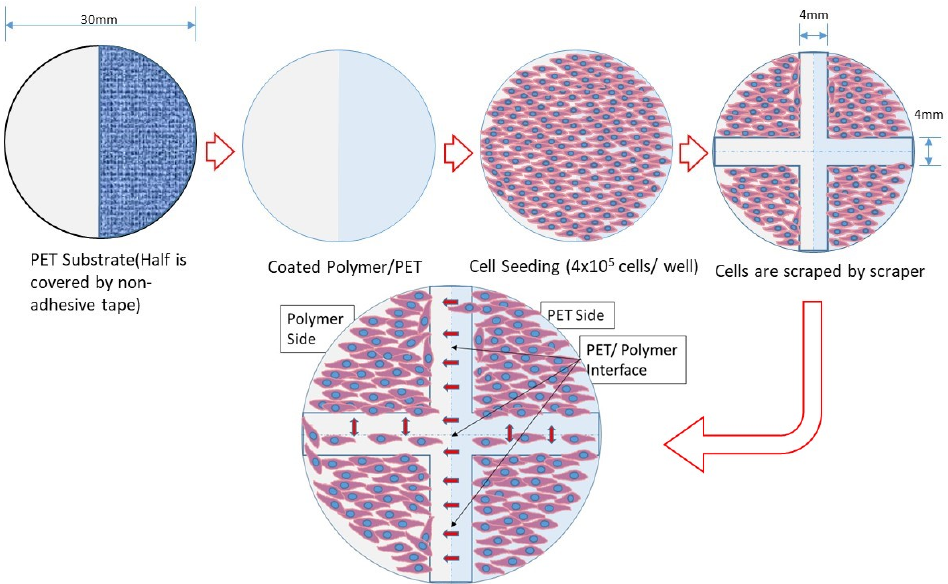
Figure 2. Schematic representation of the HUVECs migration rate measurements and observation of HUVECs migration through the coated polymer-PET interface.